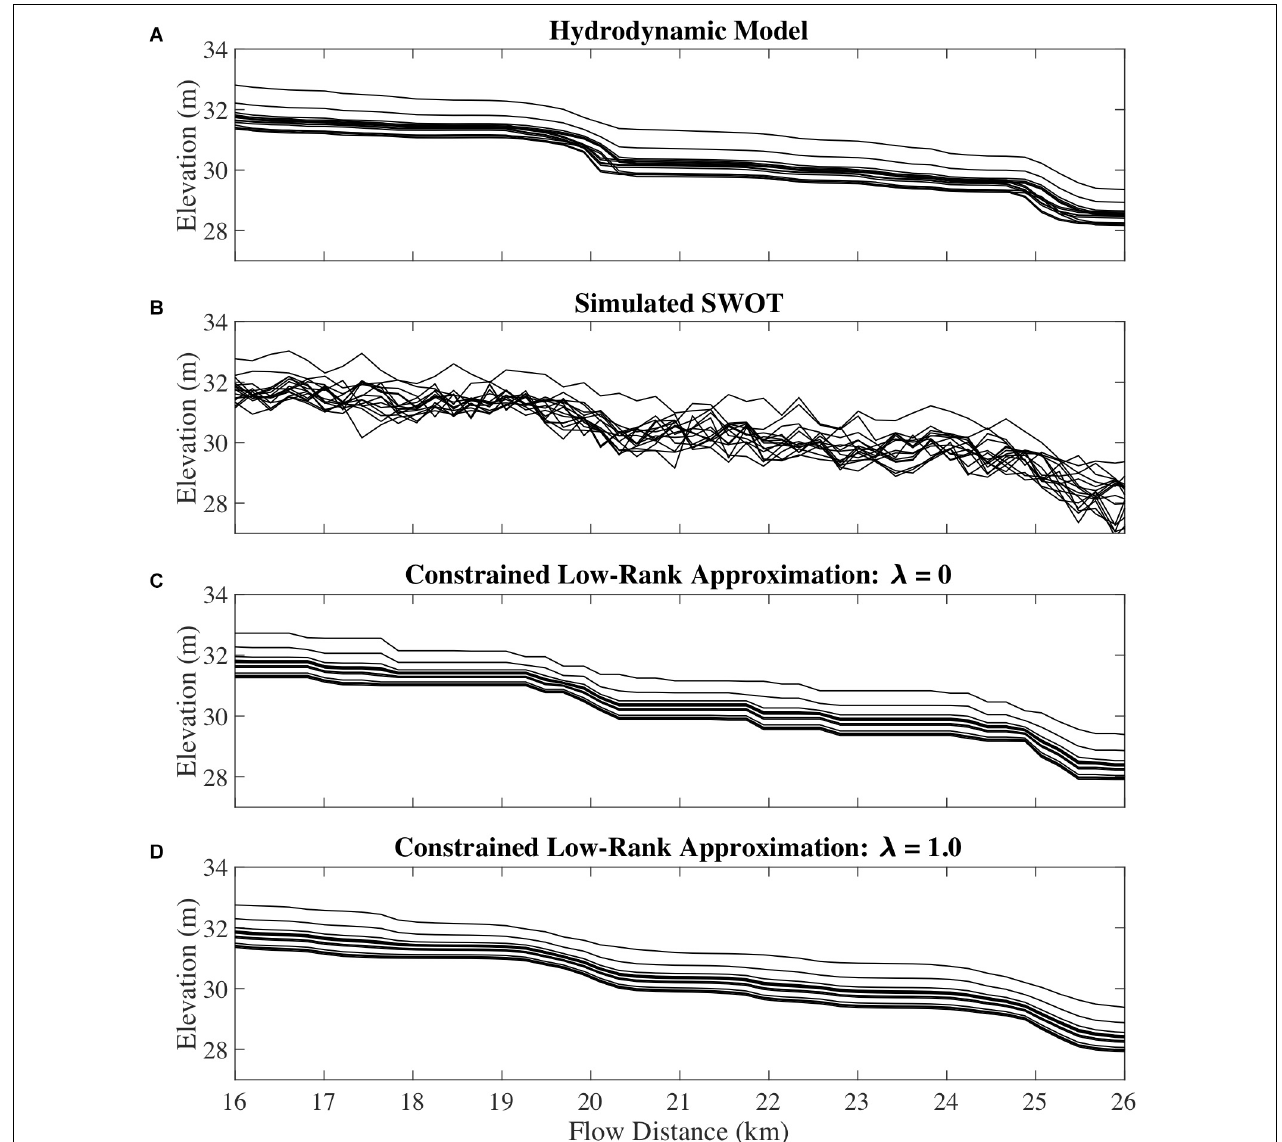
FIGURE 4 | Profile view of a 10 km section of the Sacramento River (A) before and (B) after the simulator noise is added, and (C,D) after the CLRA method is applied. One eigenvector is used in this